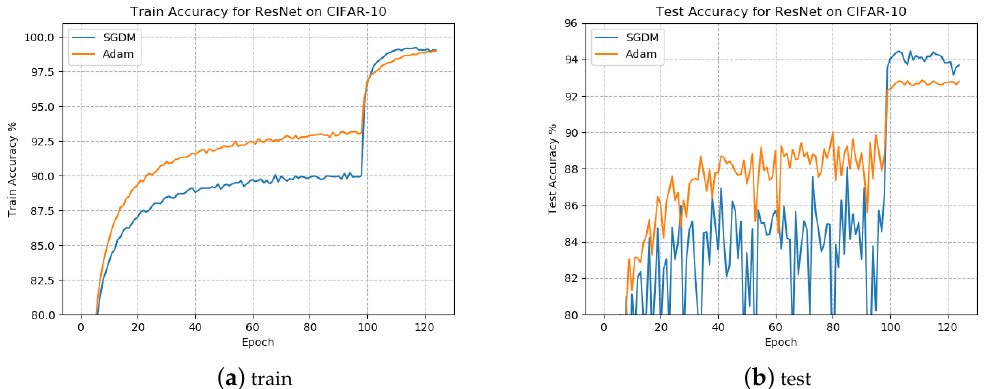
Figure 1. Training the ResNet-34 architecture on the CIFAR-10 data set with stochastic gradient descent (SGD) and Adam. Adam has a faster initial convergence speed, but the final test accuracy is lower than that of